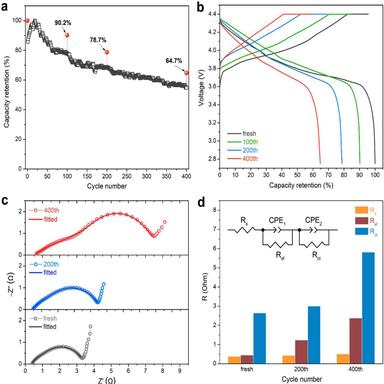
Capacity variation of the cell during cycle aging (a), voltage profiles of the cell at the fresh, 100th, 200th, and 400th (b), Nyquist plots of the AC-impedance spectra (c), and the estimated resistances (d). The measured discharge capacities at the fresh, 100th, 200th, and 400th cycles are indicated in (a). The equivalent circuit used to fit the impedance spectra, excluding the Liþ ion-diffusion (Warburg) impedance within the active materials, is shown in (d) (inset).